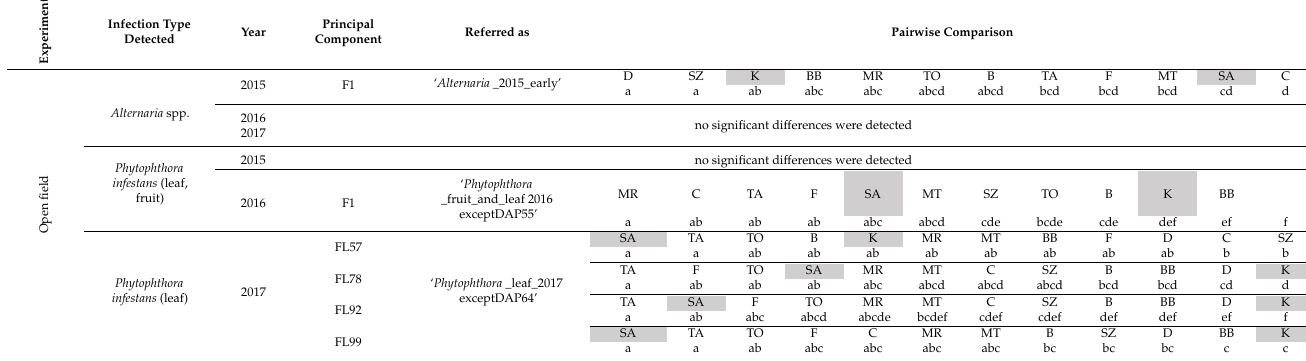
Table 11. The post hoc test results of the significant PCs obtained from the infection data of the different tomato gene bank items and control varieties regarding the open-field experiment. Different letters from lower to higher rate of infection represent significantly different groups (Games-Howell’s, p < 0.05). Abbreviations of the indeterminate Hungarian gene bank items are: B: ‘Balatonbogl á r’; C: ‘Cegl é d’; F: ‘Fadd’; GY: ‘Gyöngyös’; MR: ‘M á riap ó cs’; MT: ‘M á trafüred’;